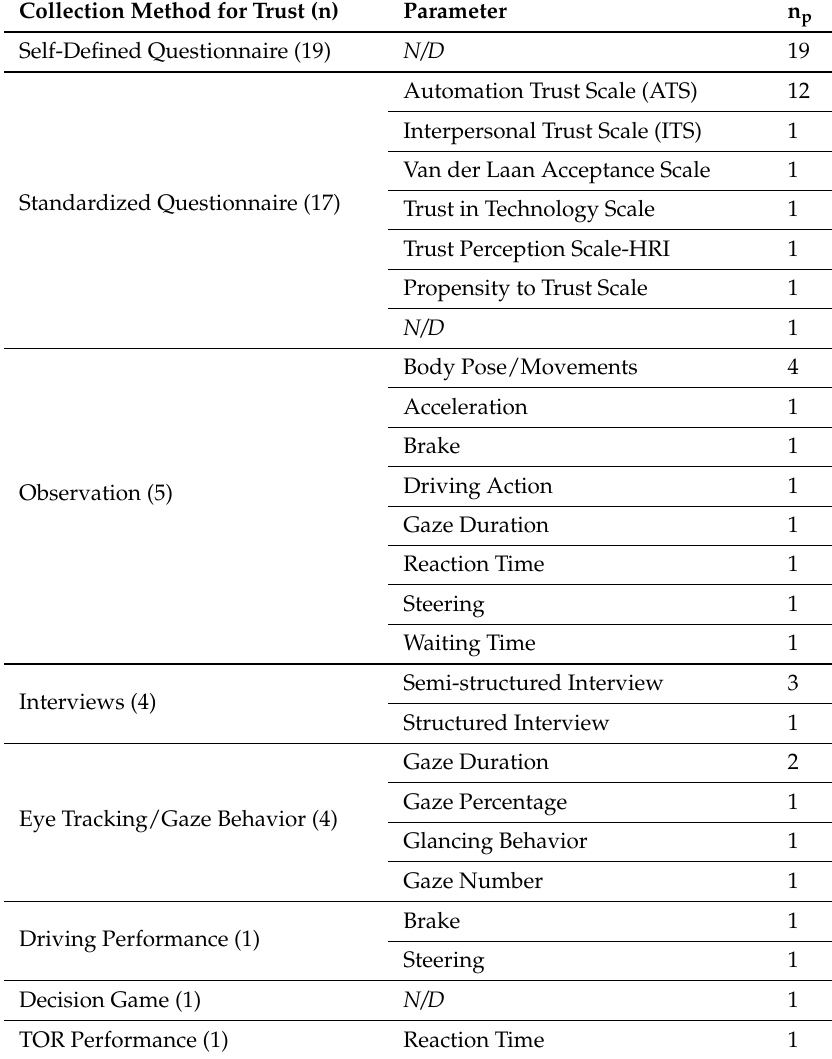
Table 3. Trust collection methods and